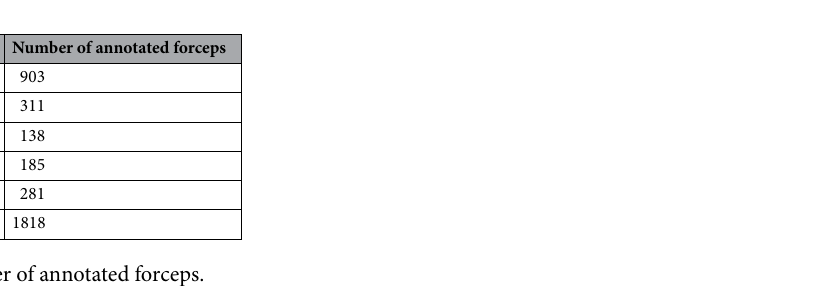
Table 1. Number of annotated